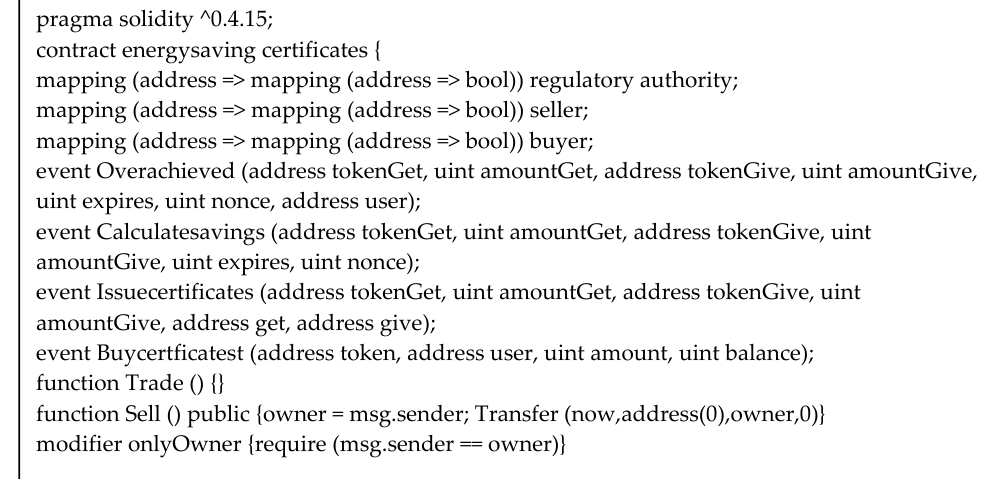
Figure 7. Components of a solidity smart contract.